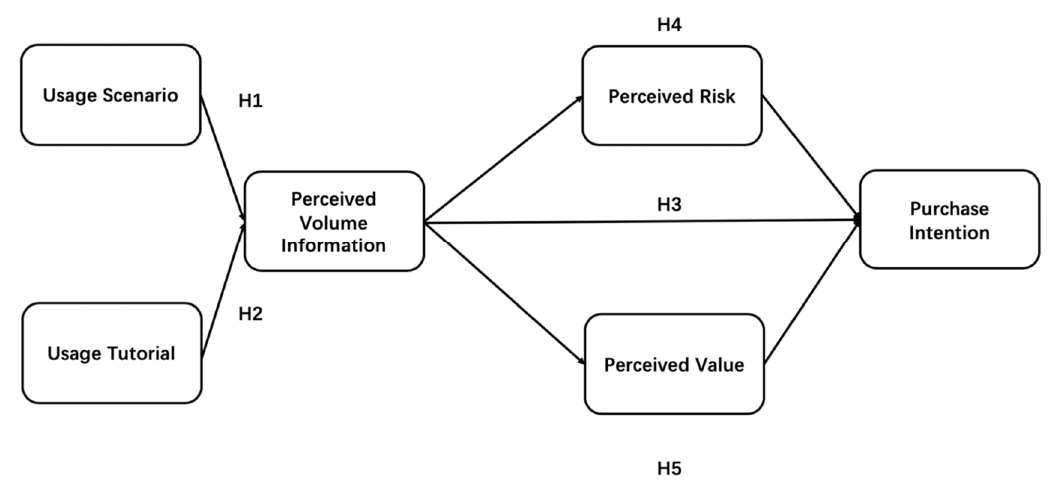
Figure 3. Hypothetical framework.